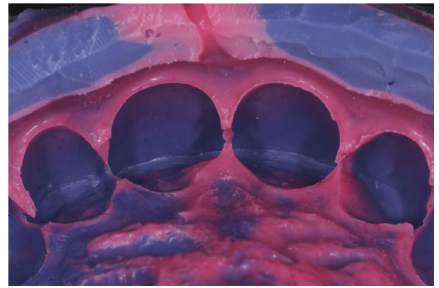
Figure 10: Detail of the final elastomeric